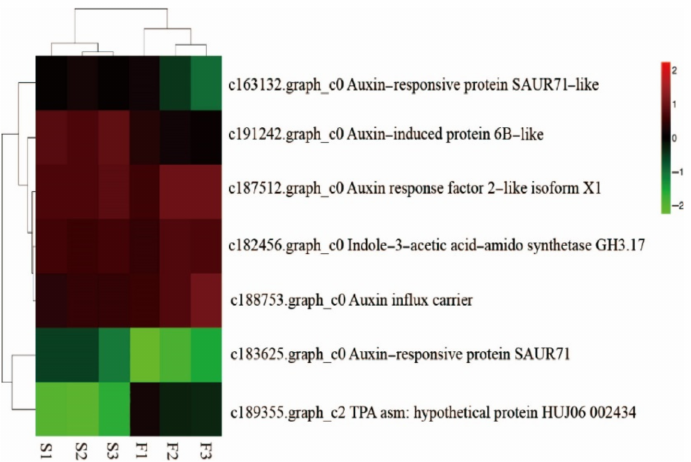
Figure 4. Cluster heat map of auxin—related differential genes between F and S cell lines of Korean pine.